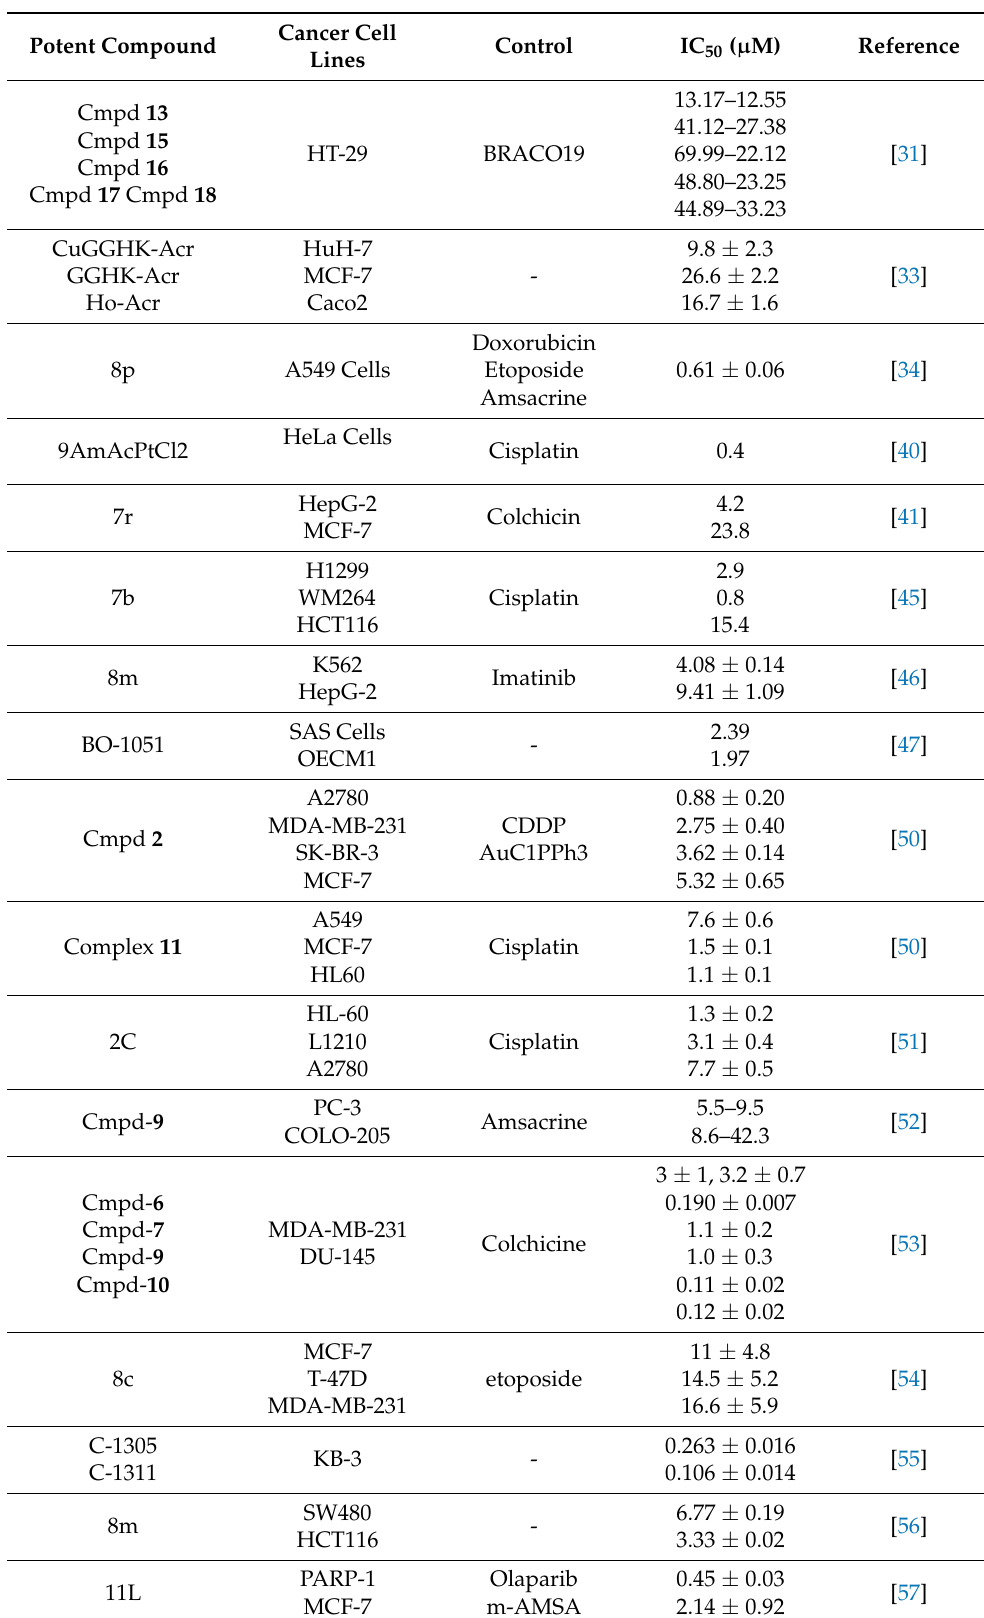
Table 16. Cont. Potent Compound